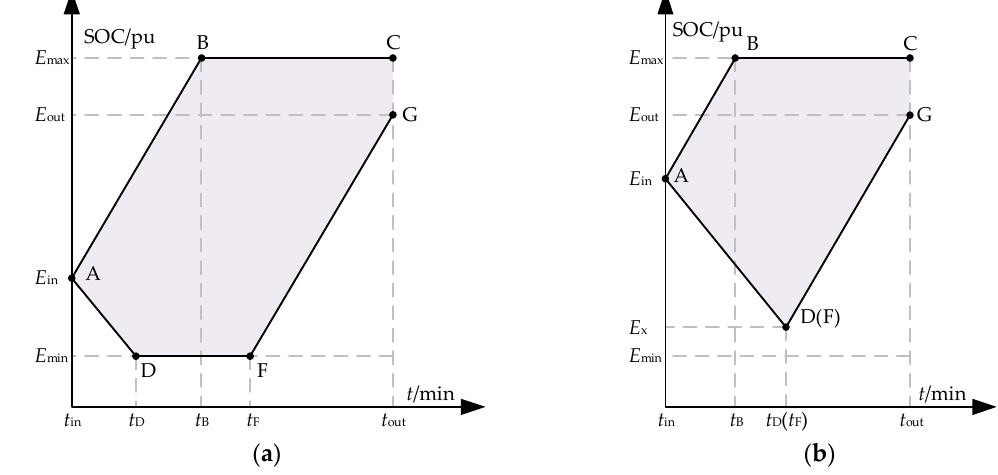
Figure 3. The charging/discharging energy boundary model of a controllable EV in vehicle-to-grid (V2G): ( a ) dischargeable to minimum state of charge (SOC, point D does not coincide with point F); ( b ) undischargeable to the minimum SOC (point D coincide with point F).